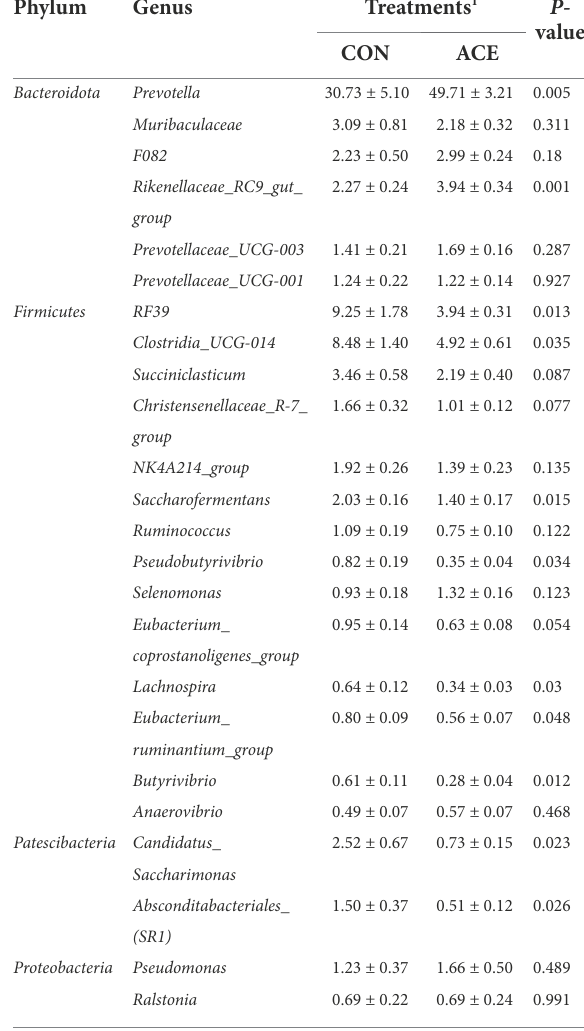
TABLE 4 Effects of dietary supplementation with NAc on the relative abundance of ruminal bacterial communities at phylum level (average relative abundance ≥ 0.5% for at least one treatment) of dairy cows.